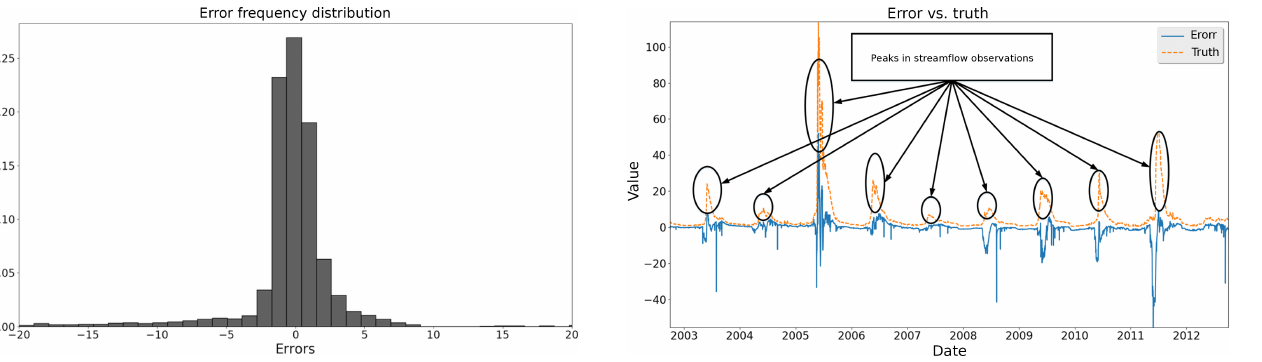
Figure 2. Comparisons between streamflow observations and pre- diction errors from a traditional calibrated PRMS model (example of Lehman Creek). The y axis value unit is cubic feet per